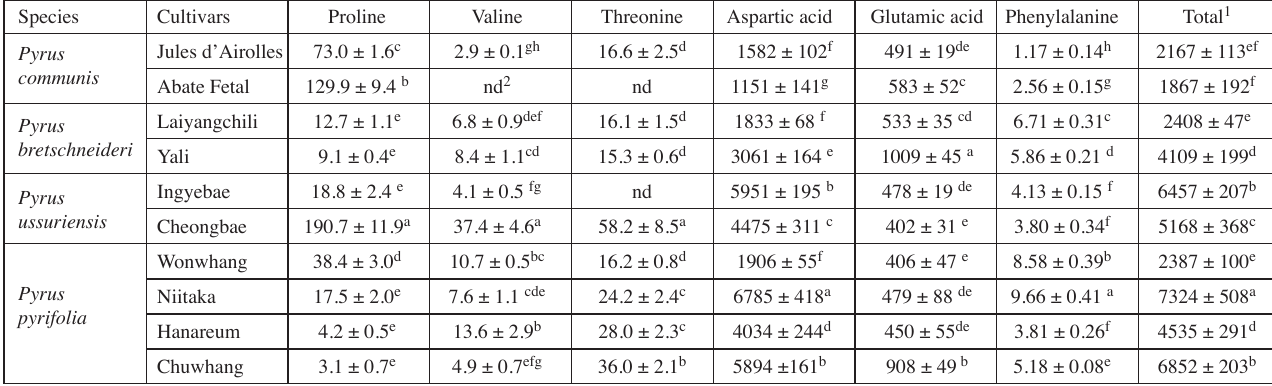
Tab. 3: Major amino-acid compositions of 10 different pear cultivars (mg/100 g DW).